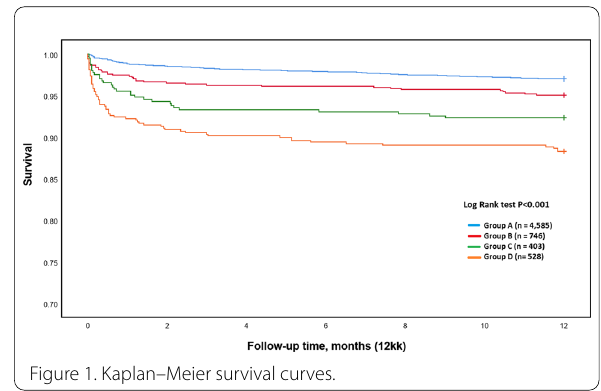
Figure 1. Kaplan–Meier survival